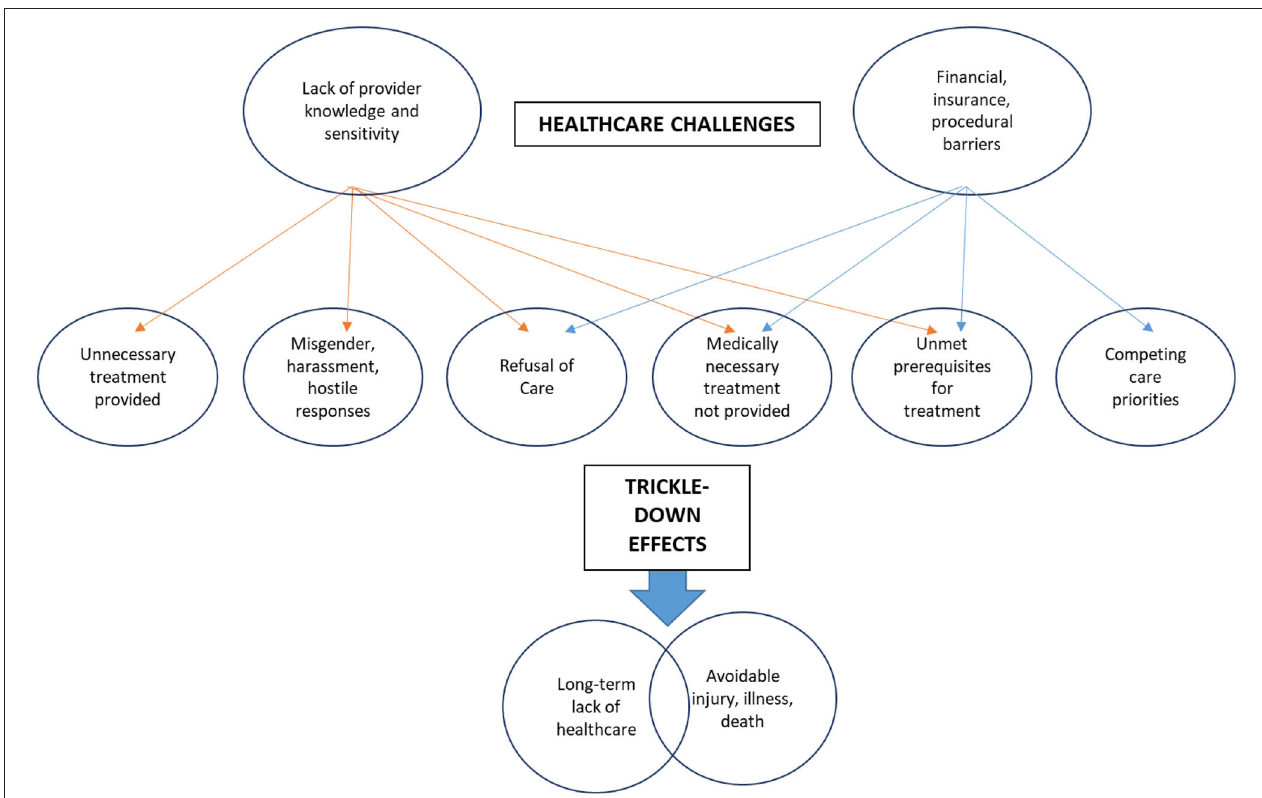
FIGURE 2 | Trickle-down effects: a model for conceptualizing larger